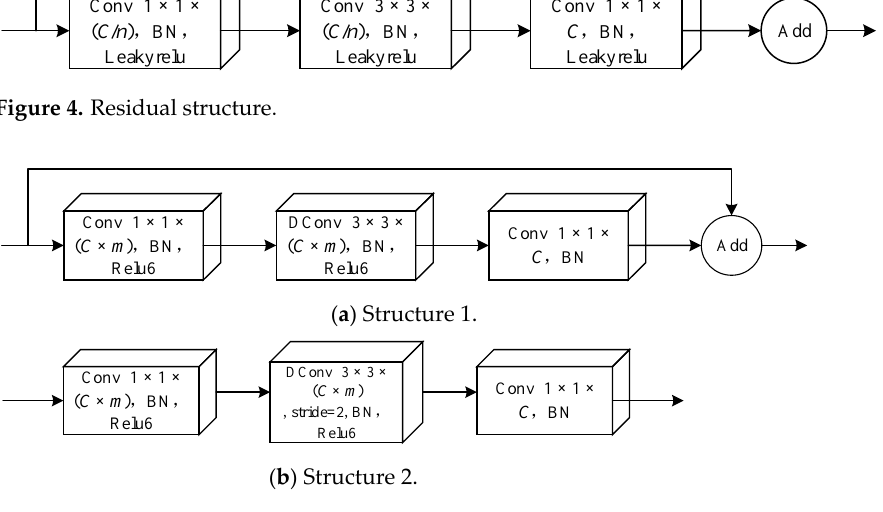
Figure 5. Inverse residual structure.